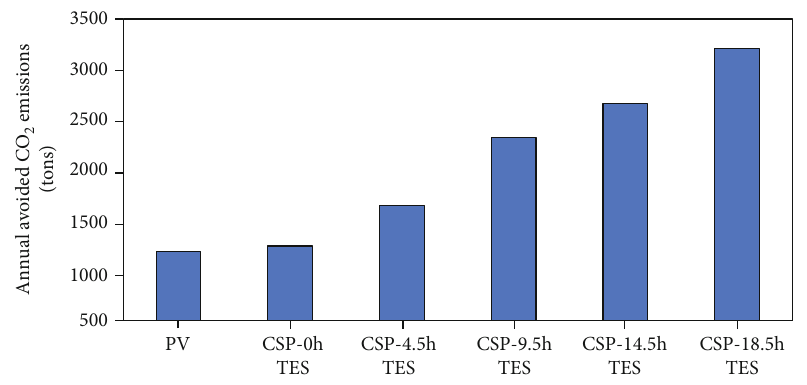
Figure 14: Annual avoided CO